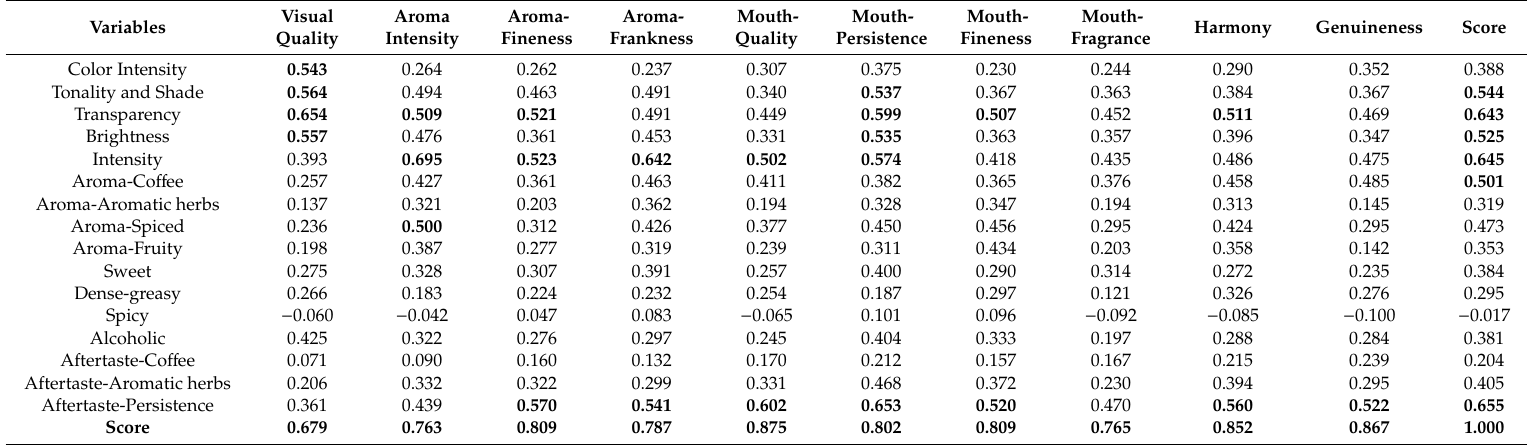
Table 5. Pearson correlation values (R) between descriptive and qualifying parameters in co ff ee liqueurs.